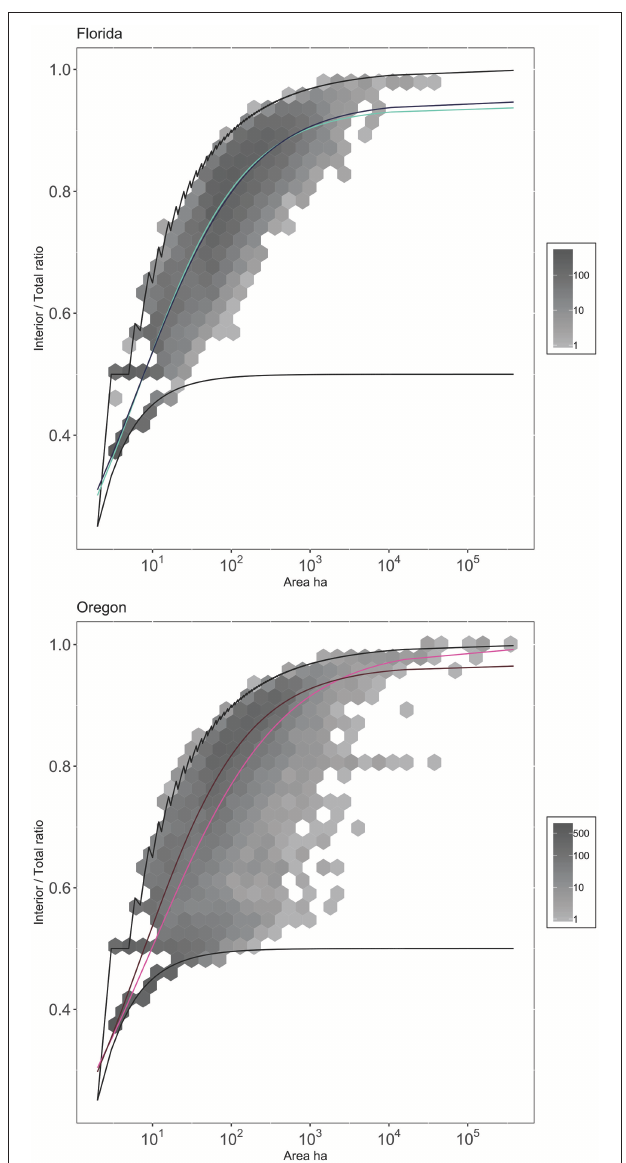
FIGURE 10 | Mean trends of Ecoregion within State. Curves match Ecoregion model curves referenced in Figure 7 . Gray hexes correspond to binned-counts of number of disturbance events. Black lines correspond to core and linear bounding cases. Parameter values associated with curves can be found in Supplementary Table 5 .